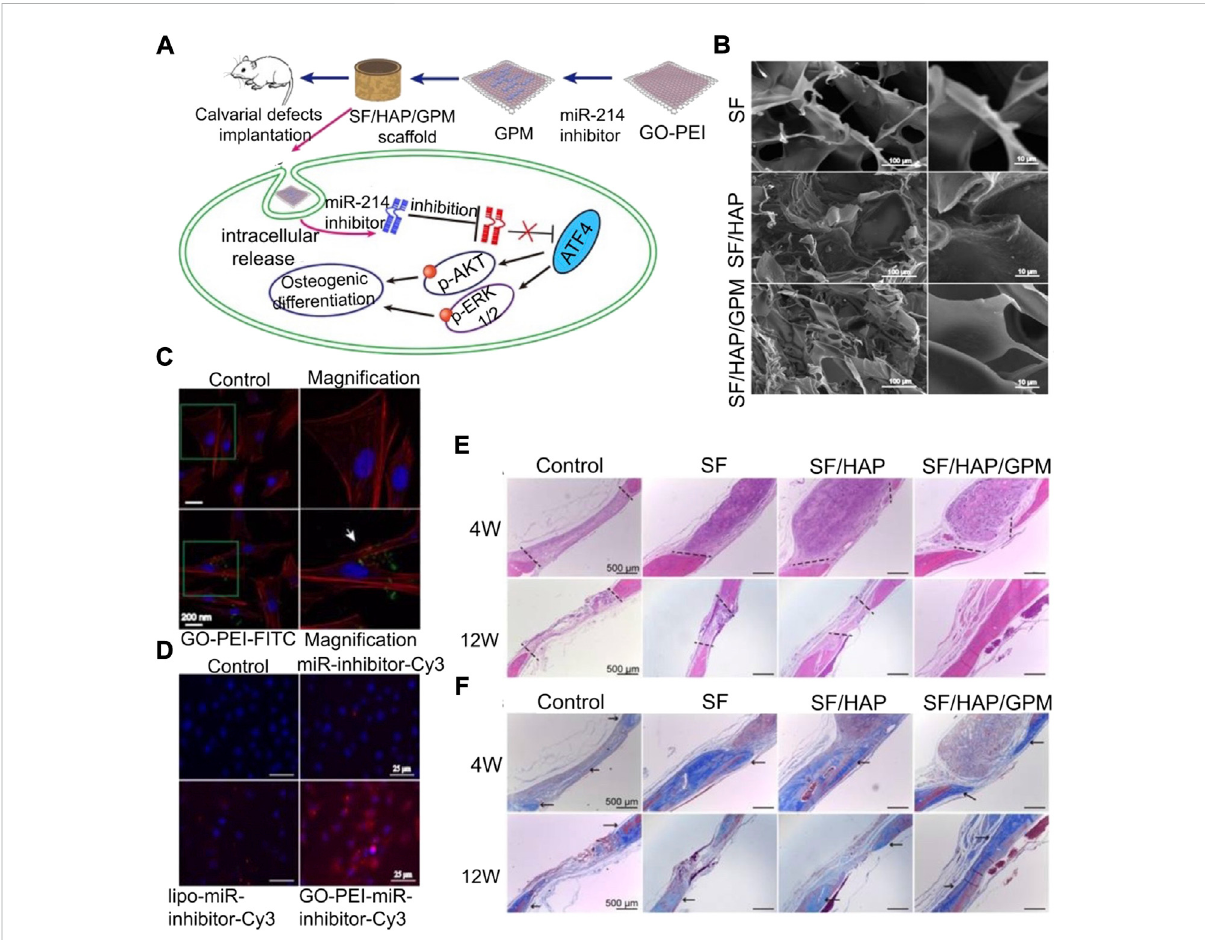
FIGURE 4 Silk fi broin/hydroxyapatite/graphene oxide – polyethyleneimine (SF/HAP/GO-PEI) scaffold carrying themiR-214 inhibitor promotesosteogenic differentiation (Ou et al., 2019). (A) Schematic diagram ofthe SF/HAP/GO-PEI scaffold carrying the miR-214 inhibitor to promote bone regeneration of bone defects. (B) SEM images of silk fi broin (SF), hybrid hydroxyapatite and SF scaffolds (SF/HAP), and SF/HAP/GO-PEI-miR-inhibitor (GPM). (C) CLSM fl uorescence images showing non-GO-PEI-treated control and GO-PEI labeled with FITC (GO-PEI-FITC) in MC3T3-E1 cells. (D) Fluorescence images showing MC3T3-E1 cells treated with control, naked miR-inhibitor, Lipofectamine 2000, and GO-PEI after 24 h incubation. H&Estaining (E) andMTC (F) wereperformedonthehistologicalsectionsofthecontrolgroup(defectswithoutscaffoldsserved),SF,SF/HAP,andSF/ HAP/GPM scaffolds after 4 and 12 weeks of implantation. Reproduced with permission from Ivyspring International